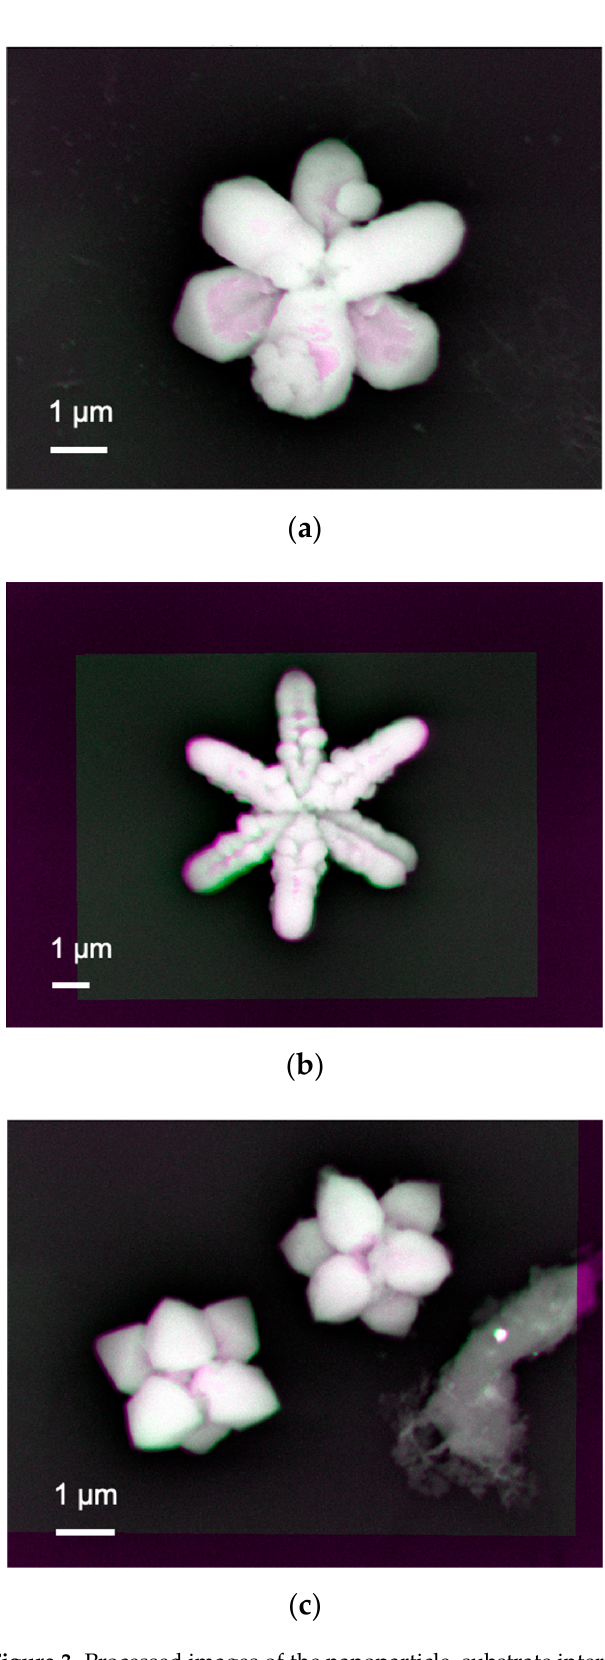
Figure 3. Processed images of the nanoparticle–substrate interfaces after subtracting two images 18 and 20 keV on the samples grown on Si/SiO 2 at pH = ( a ) 8, ( b ) 9, and ( c ) 7.